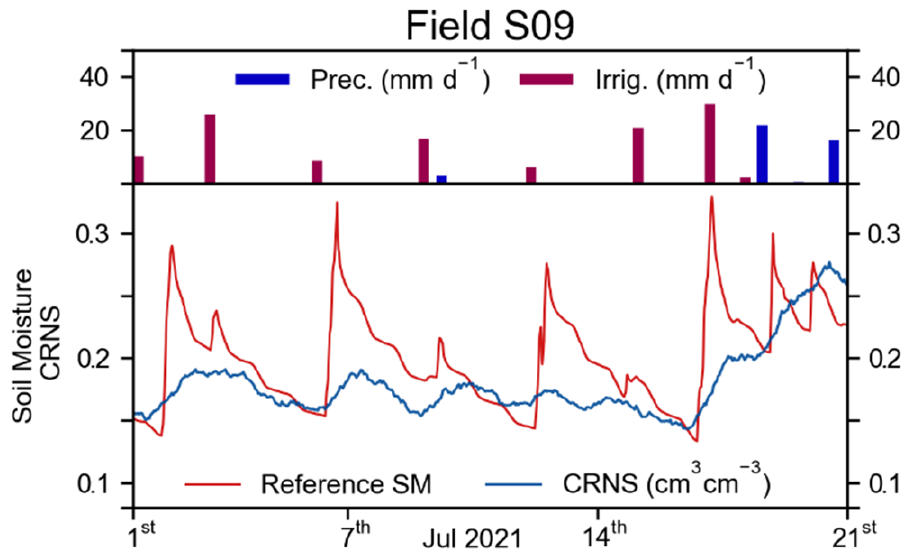
Figure A1. Text for field S09 between 1 and 21 July 2021: precipitation, irrigation, reference SM, and CRNS-derived